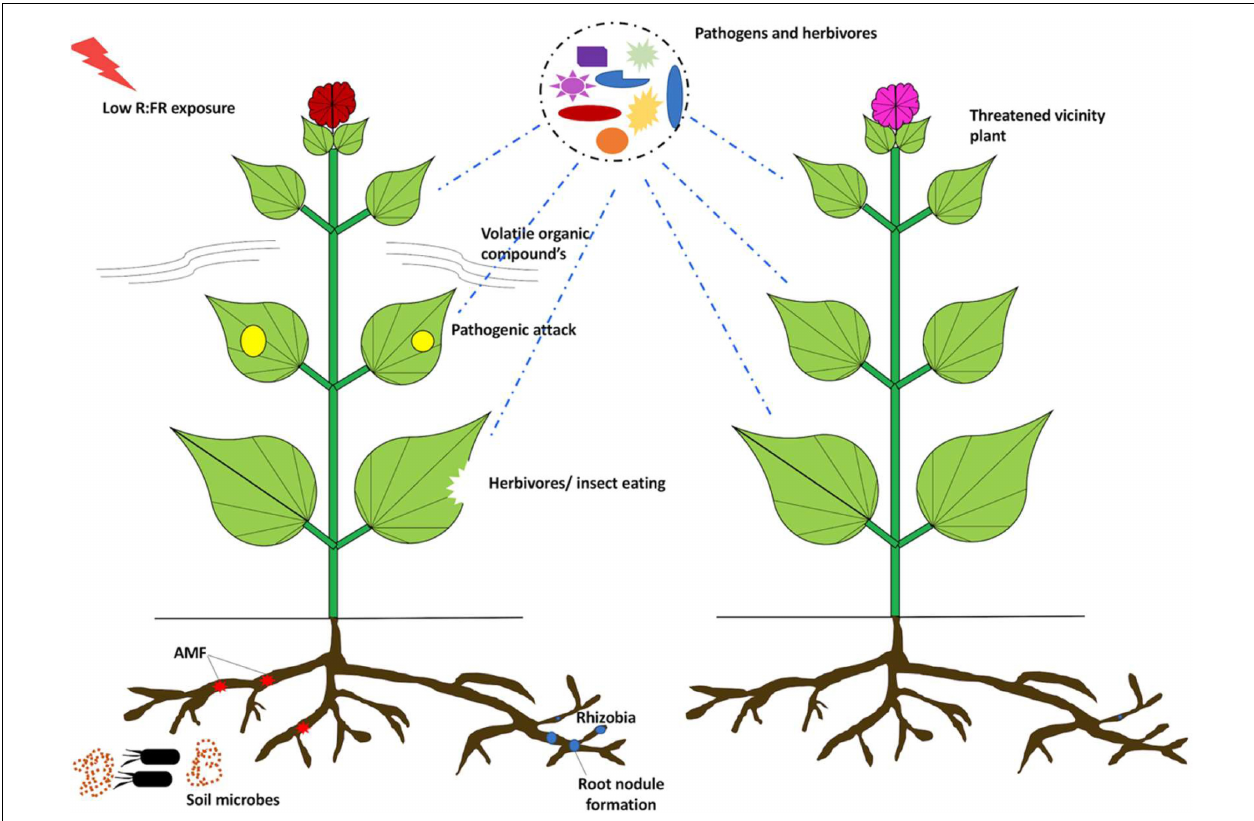
FIGURE 5 | Low R:FR modulation of plant immunity: low R:FR makes the plants more susceptible to pathogens and insects. Low R:FR exposure modulates VOC compositions, exposing plants to herbivory attack. Also, the formation of nodules and arbuscules is impacted by R:FR ratios. Arbuscular mycorrhizal fungi (AMF), volatile organic compounds